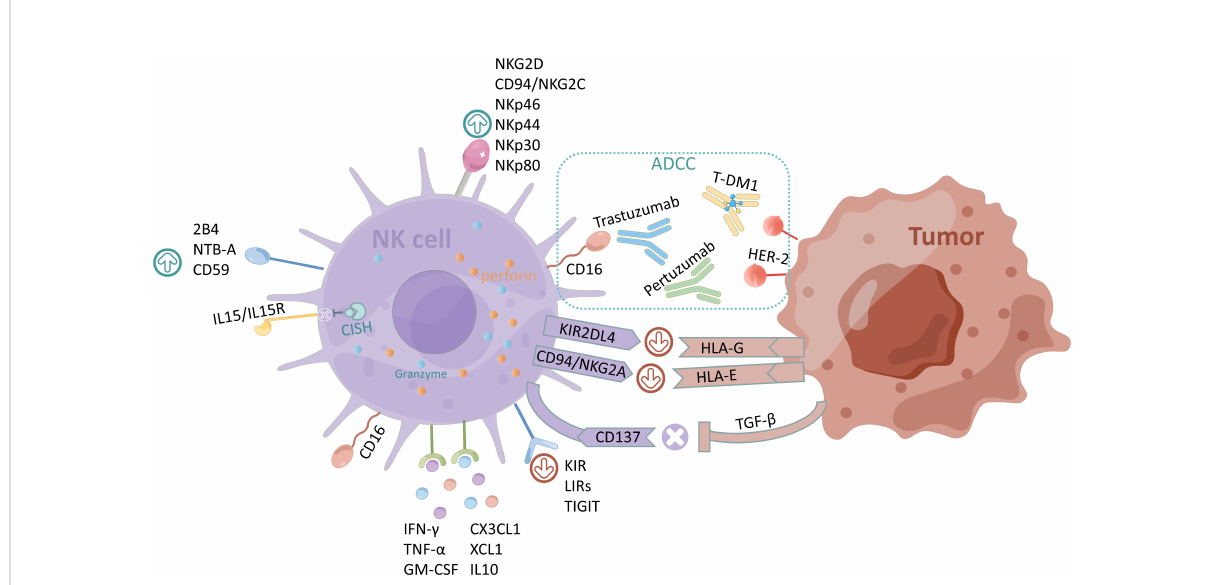
FIGURE 1 Regulatory mechanisms of NK cells and ADCC. The activating receptors of NK cells are NKG2D, CD94/NKG2C, NKp46, NKp44, NKp30, recombinant NK cell receptor 2B4 (NKR2B4, 2B4), NKp80, NTB-A, and CD59, and the inhibiting receptors are KIR, LIRs, and TIGIT. CISH normally inhibits IL-15/IL15R signaling in NK cells. The main cytokines secreted by NK cells are CX3CL1, chemokine (C motif) ligand 1 (XCL1), IL10, IFN- g , TNF- a , and GM-CSF. HLA-G and HLA-E expressed by tumor cells bind to inhibitory receptors KIR2DL4 and CD94/NKG2A of NK cells respectively to exert immunosuppressive effects; CD137 counteracts the immunosuppression caused by the overexpression of TGF- b by tumor cells. The fi gure was drawn by